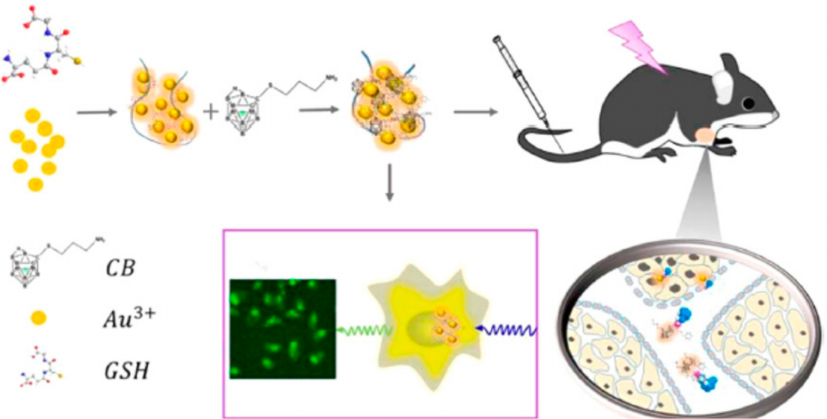
Figure 8. Illustration of the bioimaging process for cancer cells using gold nanocluster with carborane derivative (reprint from Ref.